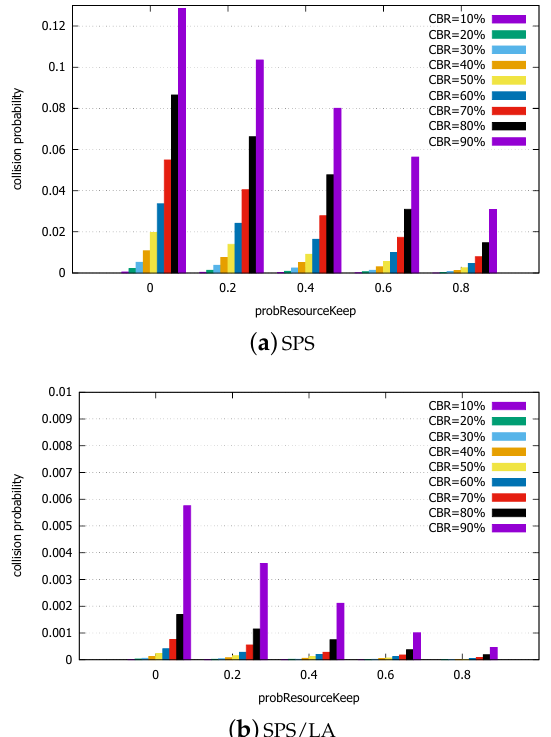
Figure 10. Collision probabilities under varying probResourceKeep , heavy load. ( a ) SPS. ( b )